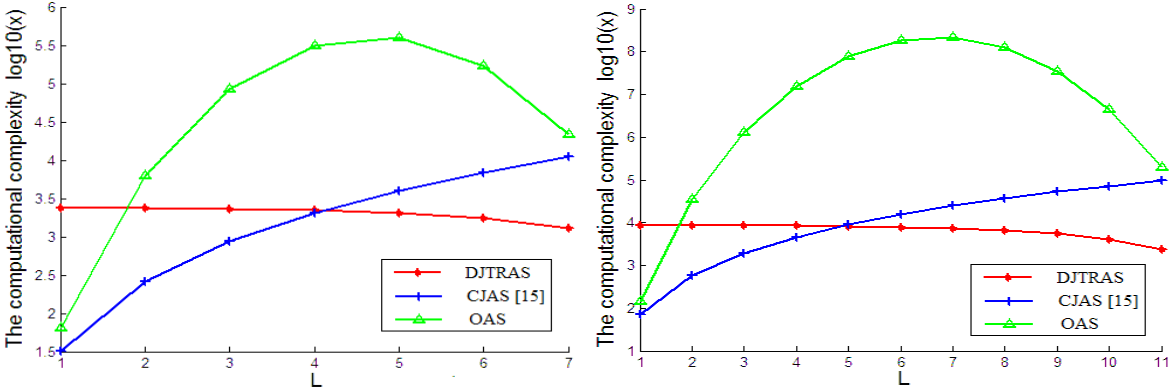
Fig. 2 Comparison to the CC of 8 × 8 MIMO AS system Fig. 3 Comparison to the CC of 12 × 12 MIMO AS